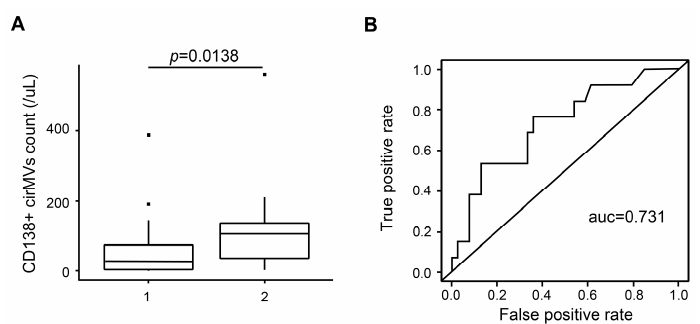
Figure 6. CD138+ cirMV counts positively correlate with renal impairment. The enrolled 61 de novo patients with MM were divided into two groups according the levels of SCr (group 1, SCr < 2 mg/dL, n = 45; group 2 SCr ≥ 2 mg/dL, n = 16). The levels of CD138+ cirMVs were significantly higher in group 1 than in group 2 ( A , p = 0.0138), and the ROC value for using CD138+ cirMV counts to diagnose RI in de novo patients with MM was 0.731 ( B ).